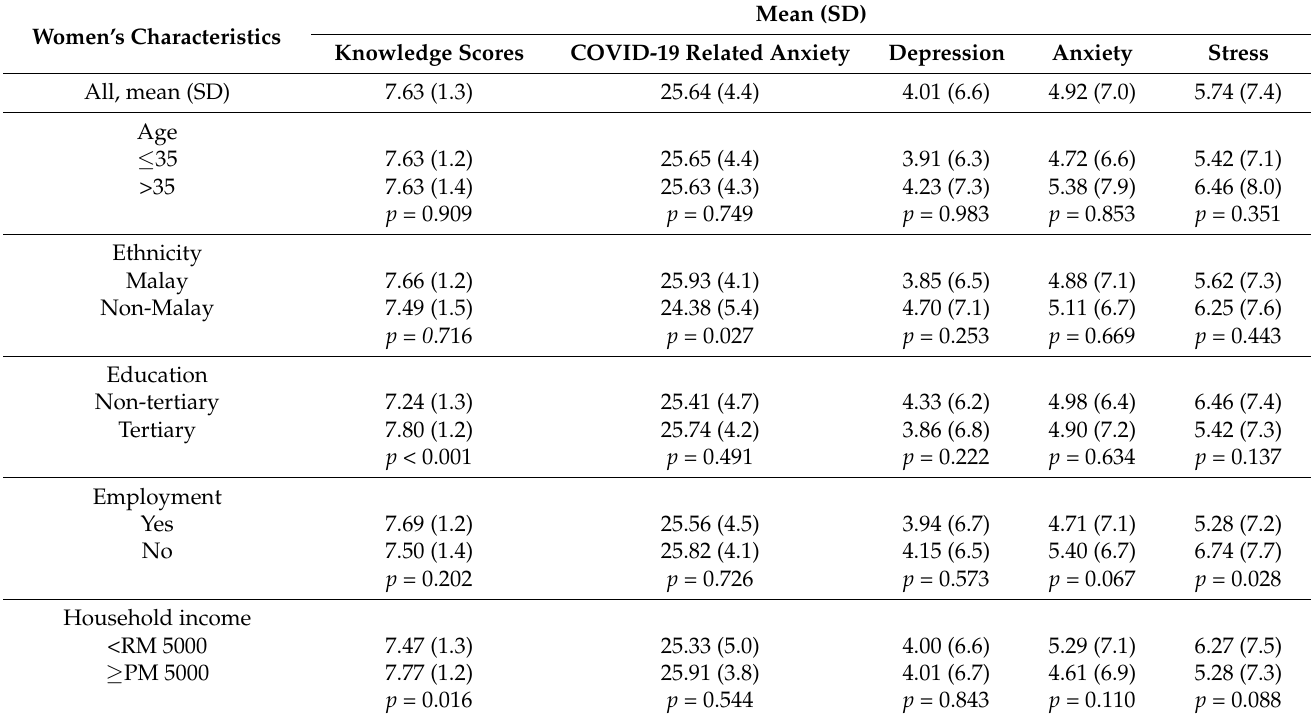
Table 5. Comparisons of mean scores for Knowledge, COVID-19 anxiety, Depression, Anxiety, and Stress between different maternal